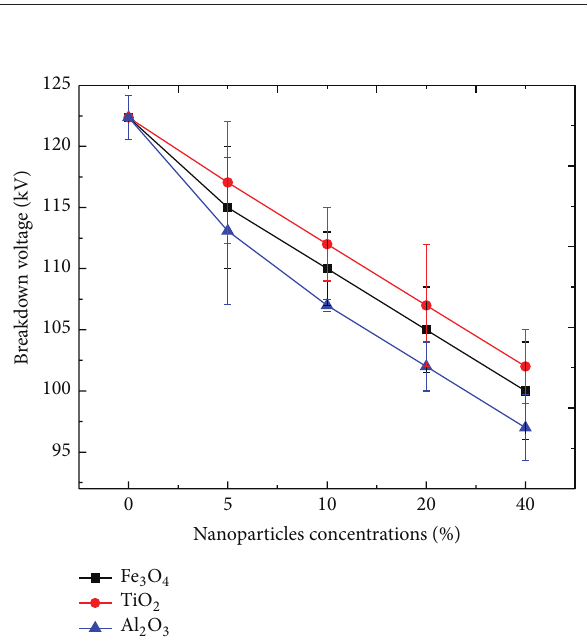
Figure 3: Negative impulse breakdown voltages of different nanofluids with different concentrations (15mm gap